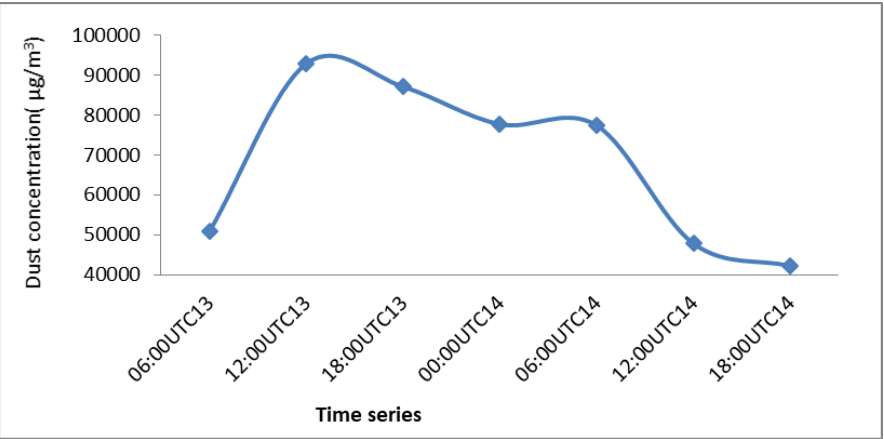
Figure 19. Surface dust concentration series (µg/m 3 ) simulated with AFWA scheme for storm 14 February 2018.